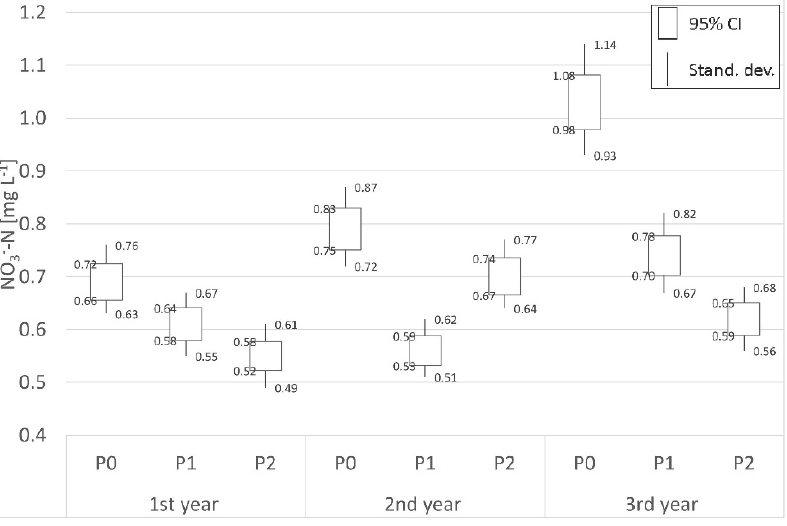
− -N in groundwater under peatland 3